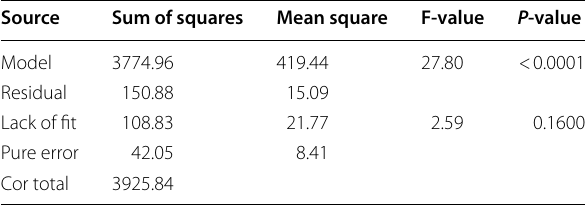
Table 2 Analysis of variance for quadratic model